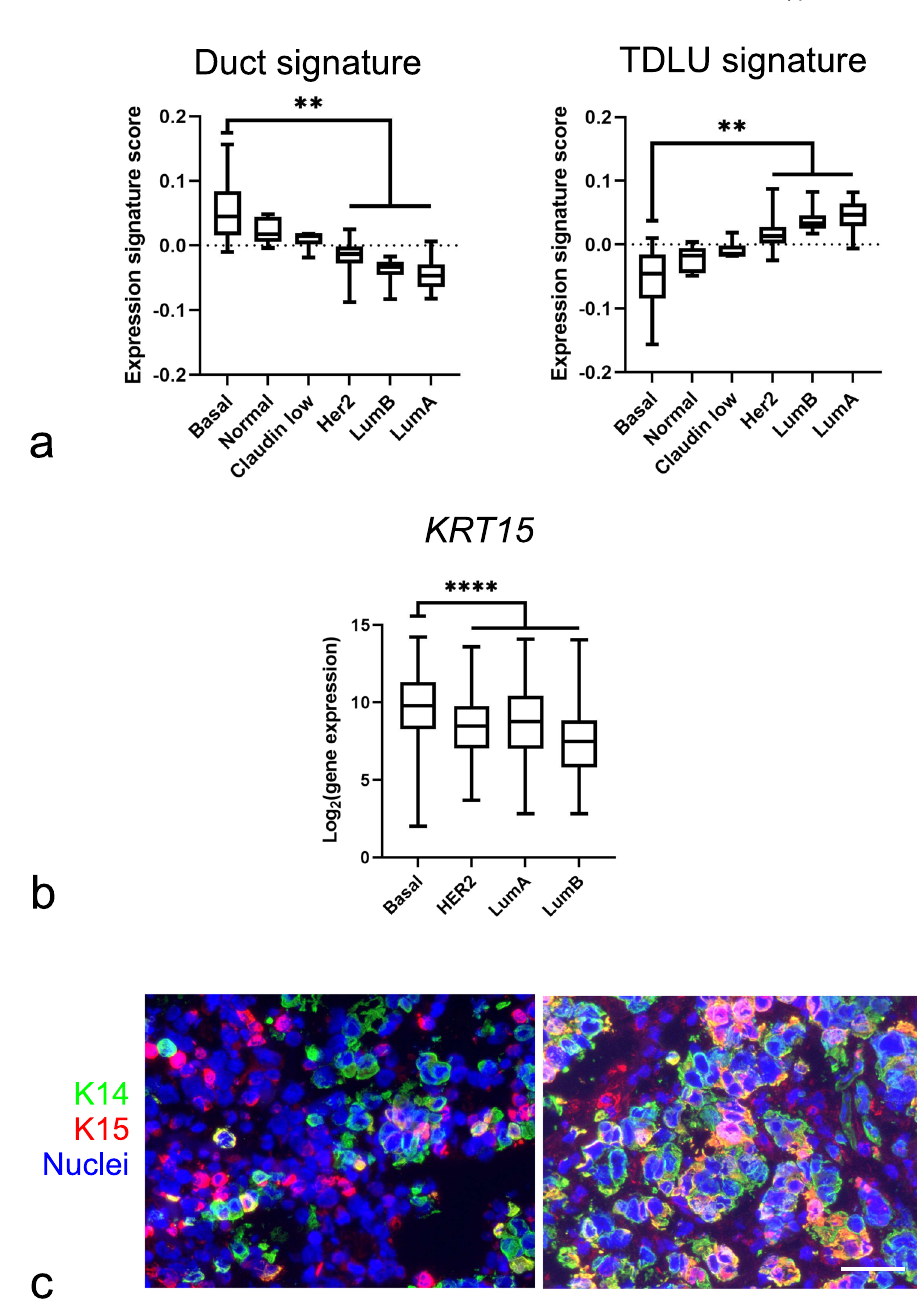
Fig. 4 Correlation between expression pro fi les of duct- and TDLU-derived normal luminal cells and breast cancer subtypes. a Whisker box plots of expression signature scores comparing DEGs of duct- (left) and TDLU-derived (right) luminal cells with gene expression pro fi les of different breast cancer subtypes (basal-like (Basal), normal-like (Normal), Claudin low (Claudin low), HER2-enriched (Her2), luminal type B (LumB), and luminal type A (LumA)). Boxes represent median ± quantiles. Whiskers indicate the minimum and maximum values. ** p < 0.01 by Kruskal – Wallis test with Dunn ’ s multiple comparisons test. b Whisker box plot showing KRT15 gene expression in the different breast cancer subtypes. KRT15 is signi fi cantly upregulated in basal-like breast cancer compared to the other breast cancer subtypes ( n = 2164, GENT2 database). Boxes represent median ± quantiles. Whiskers indicate the minimum and maximum values. **** p < 0.001 by one-way ANOVA with Tukey ’ s multiple comparison test. Source data are provided as a Source Data fi le. c Representative fl uorescence multicolor imaging of cryostat sections of basal-like breast carcinomas stained for K15 (red), K14 (green), and nuclei (blue). Nine out of 36 basal-like breast carcinomas stained positive for both K15 and K14. Scale bar = 50 μ